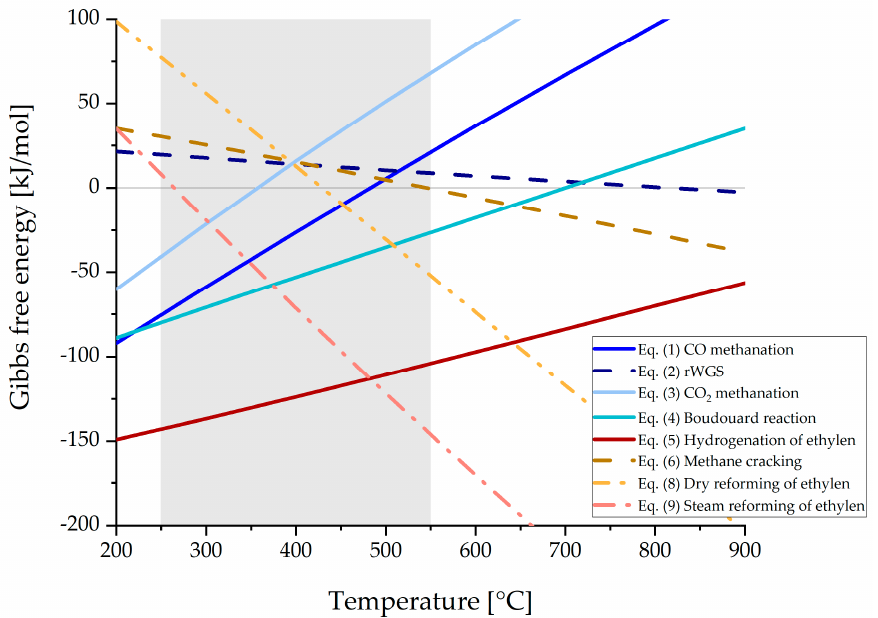
Figure 5. Gibbs free energy for relevant reactions for syngas methanation applications, generated with HSC 10.